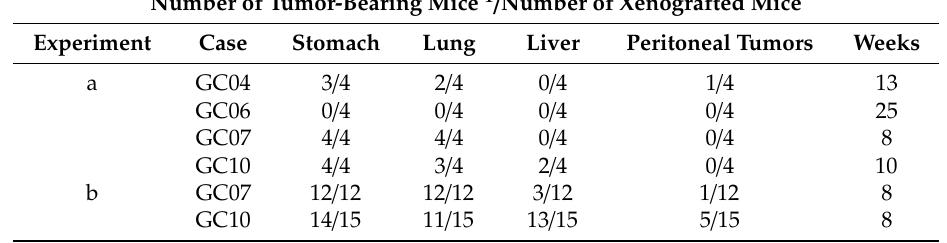
Table 1. Number of tumor-bearing mice per total of NSG mice implanted with luciferase-encoding gastric PDX cells into gastric subserosa in two independent